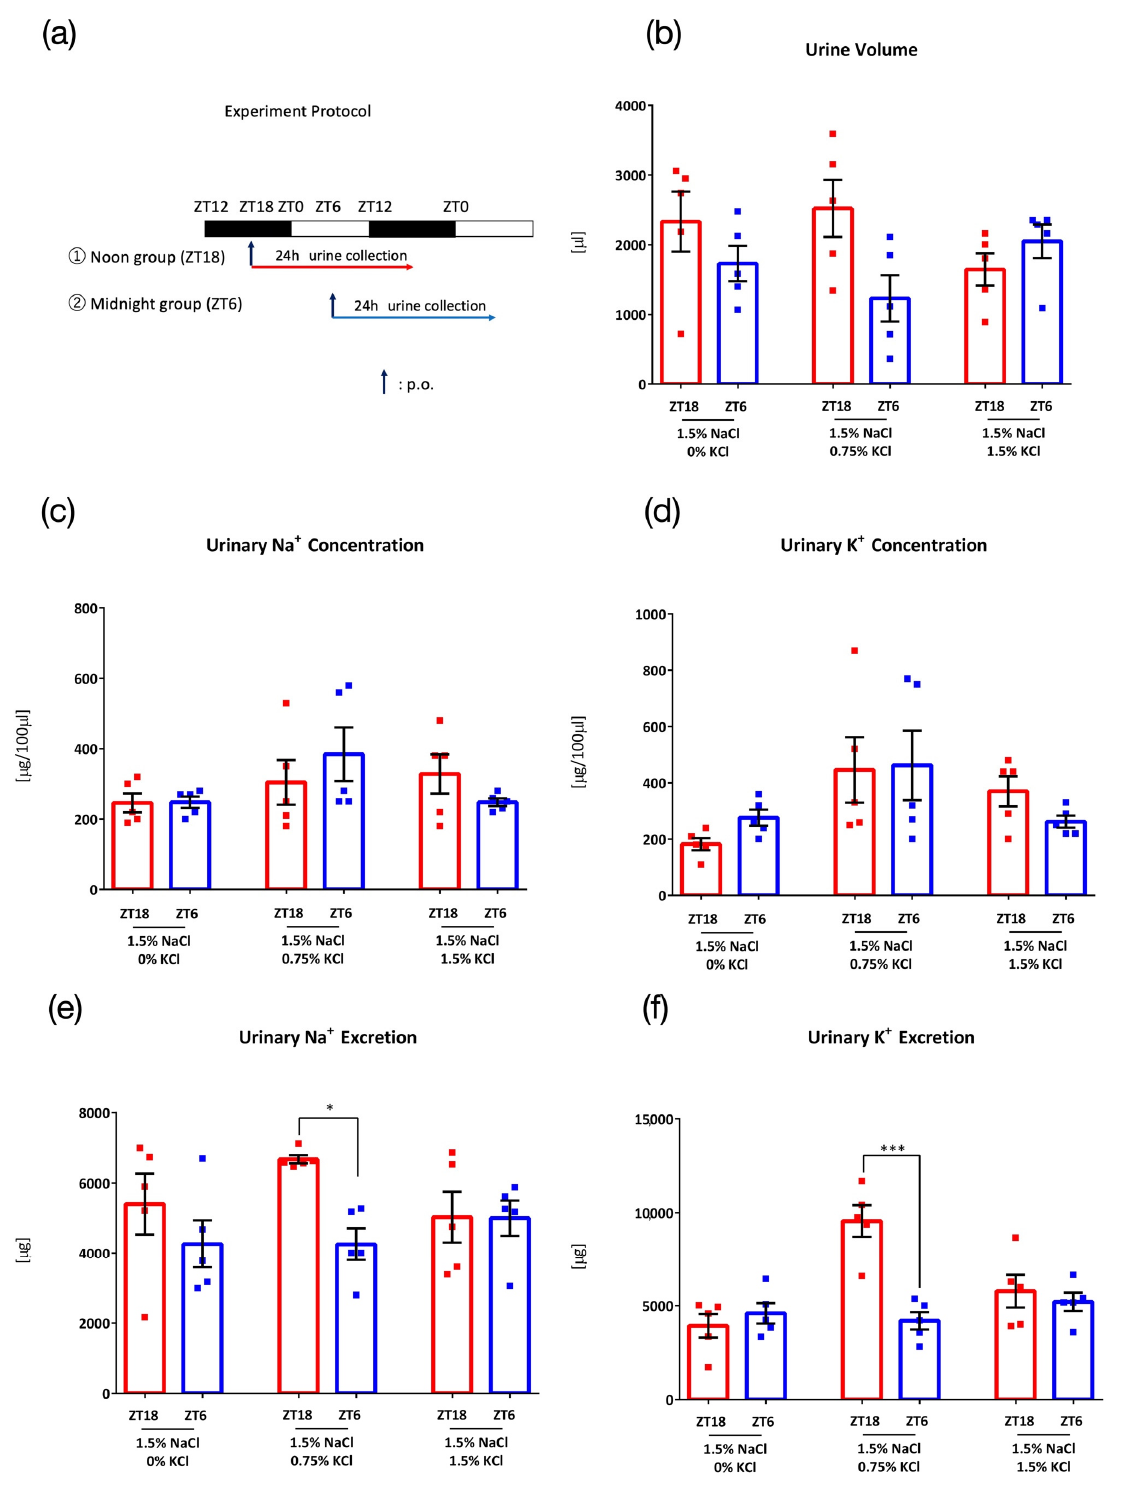
Figure 2. Urinary excretion after administration of salt load of different KCl concentrations. ( a ) Experimental protocol, ( b ) Urine volume. ( c ) Urinary Na + concentration, ( d ) Urinary K + concentration, ( e ) Urinary Na + excretion, * p < 0.05 (vs. ZT6) Benjamini, Krieger and Yekutieli’s Two-stage. ( f ) Urinary K + excretion, *** p < 0.001 (vs. ZT6) Sidak. Data are represented as mean ± SEM (ZT18 group: n = 5, ZT6 group: n = 5) .